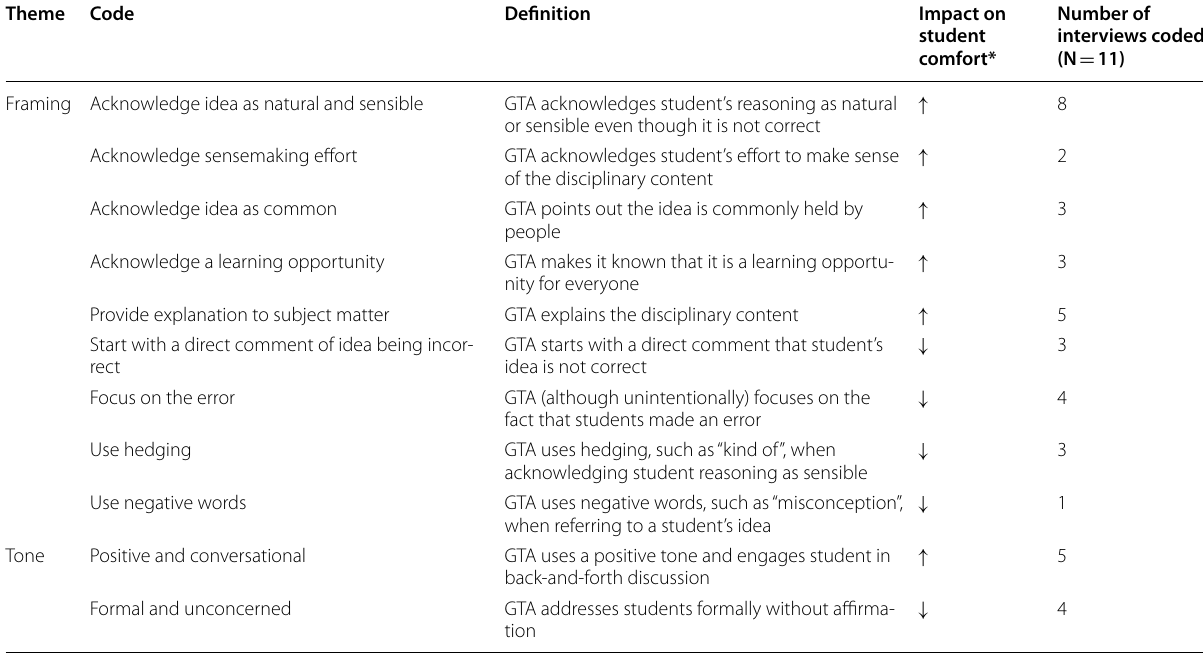
* ↑ Indicates student comfort is increased, and ↓ indicates student comfort is decreased